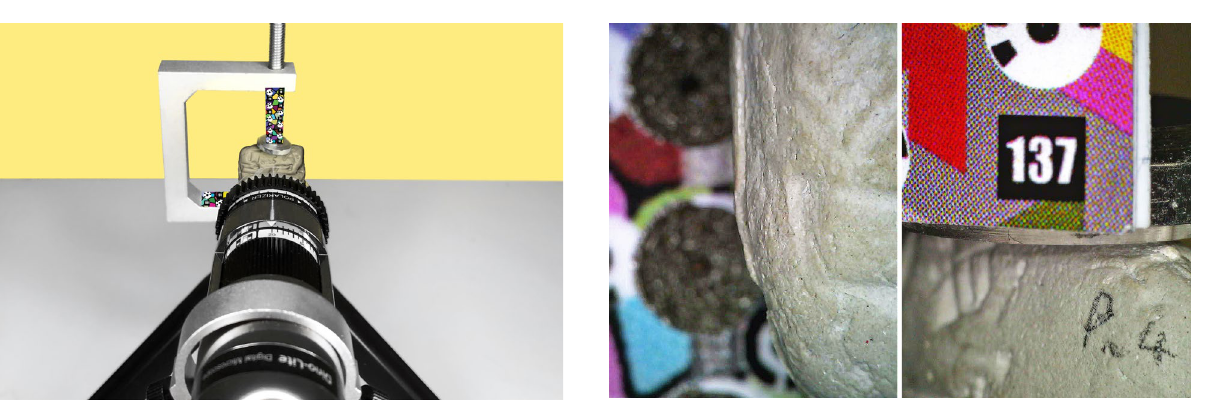
Figure 8 . Different ability to focus on target and object at the Figure 7 . Detail of the positioning of the tablet in the clamp for same time using the calibrated plate (left) or the clamp (right). the second acquisition test.